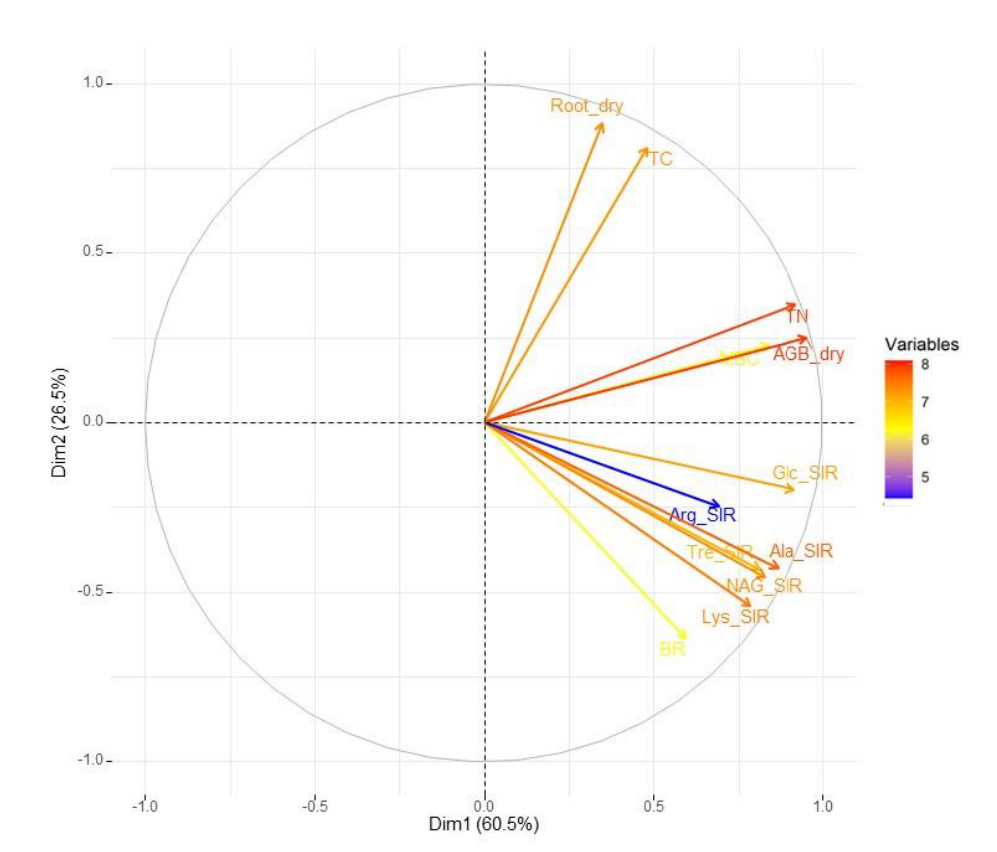
Figure 1. Variable correlation PCA plot describing the relationships between all variables. Color scale (of arrows) from blue to red indicates the increasing ‘weight’ of variables.